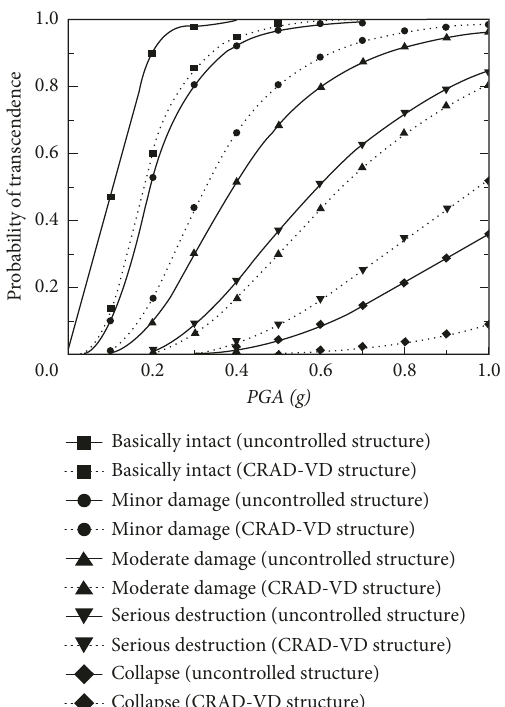
Figure 13: Comparison of fragility curve of the assembled monolithic concrete structure of uncontrolled and additional